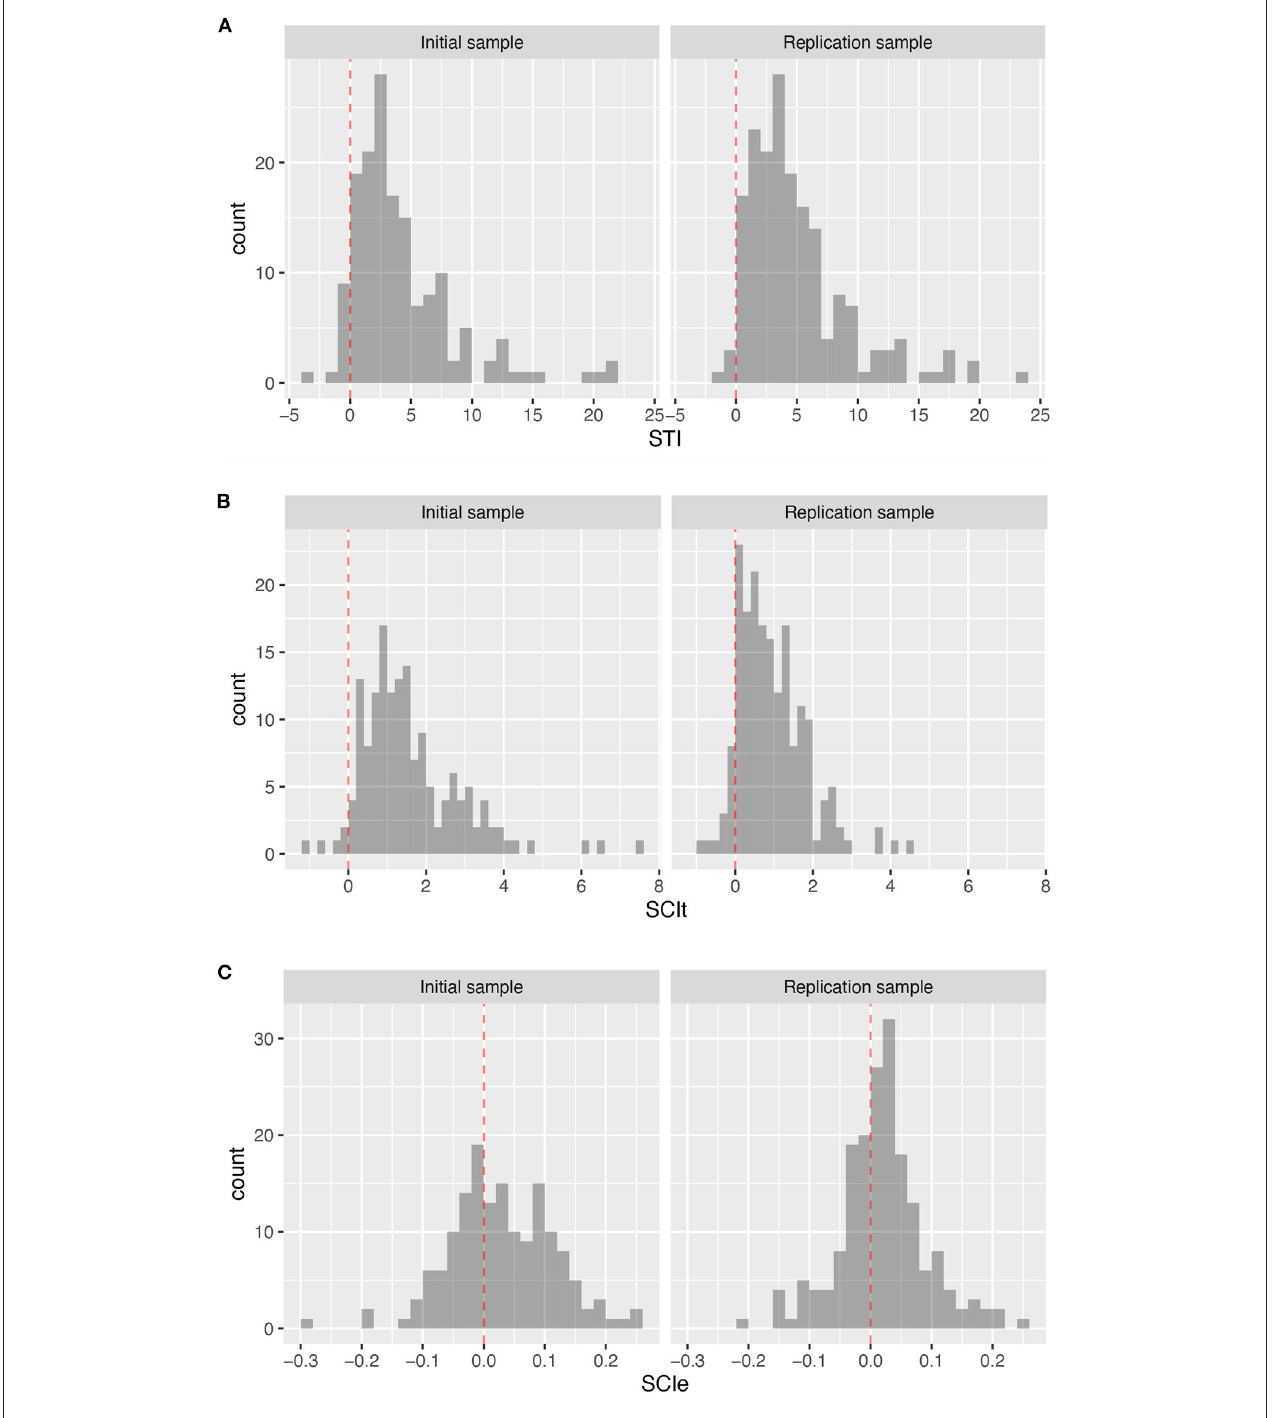
FIGURE 5 | Distribution of derived measures at the individual level. (A) Distribution of the estimate of the setup time STI . (B) Distribution of preparation time based SCI t . (C) Distribution of error-based SCI e